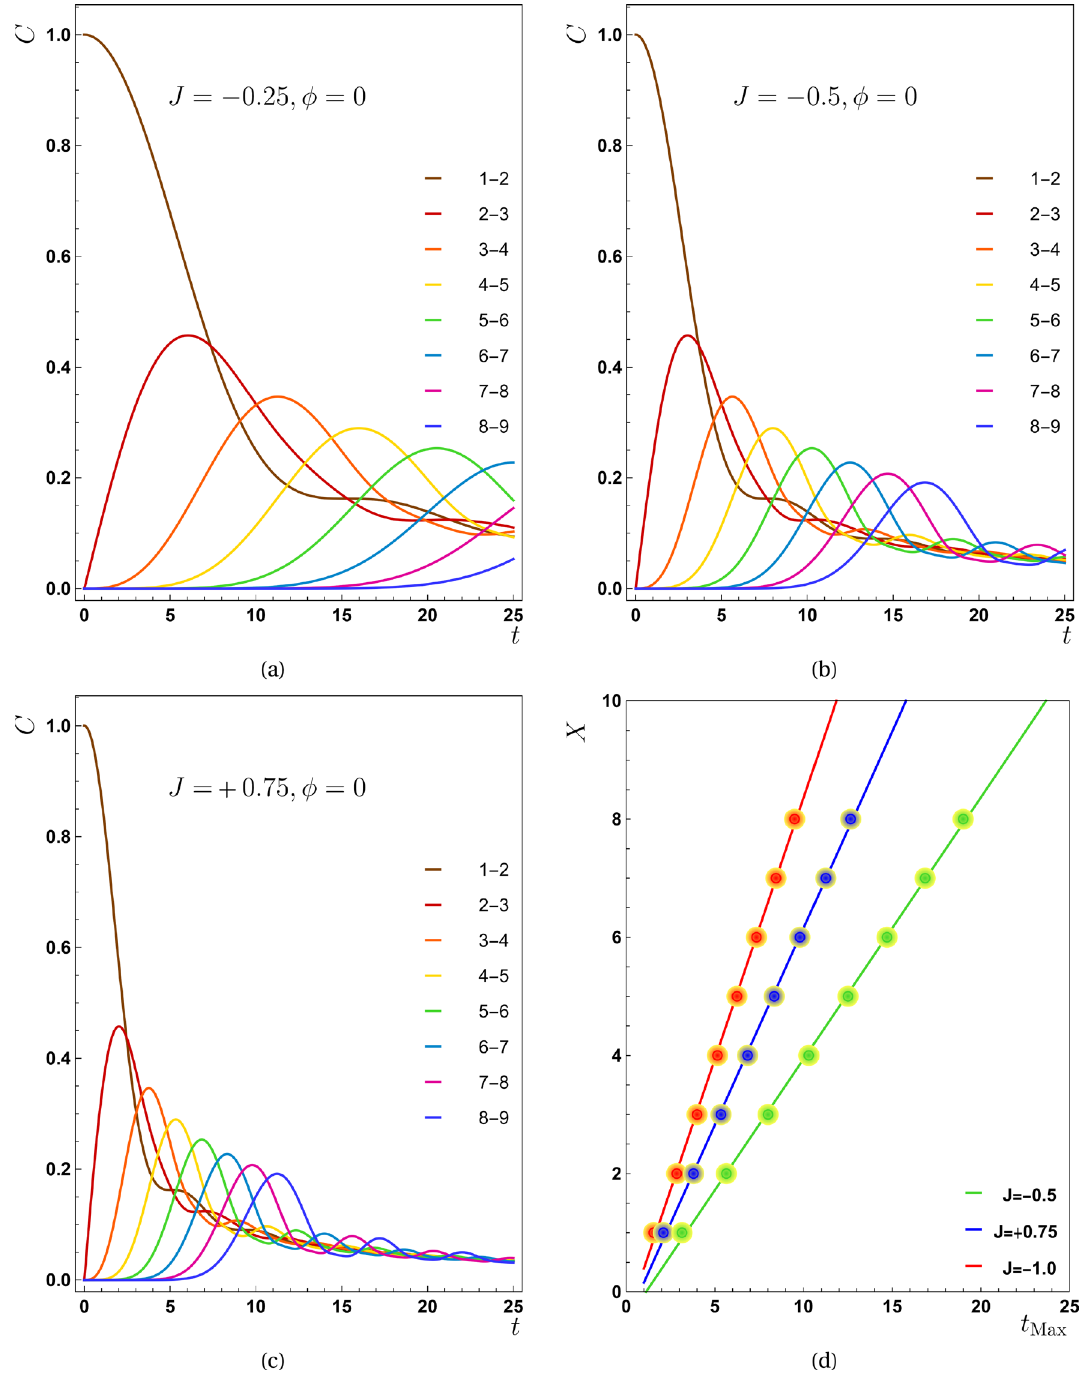
0.25 , ( b ) 0, D 0 ) the concurrence as a function of time t ( a ) J Figure 1. In the first scenario ( J = − = = 0.5 , ( c ) J 0.75 . As can be seen, the maximum value of the concurrence function for the various pairs J = − = occurs in the shorter time instances as J increases, and the graphs become more compact as a result. The t Max for different values of exchange interaction is presented in panel ( d ), from which the value diagram of X − 0.0005 , for J 0.5 is 0.4410 0.75 and J 1.0 , this quantity equals with of propagation speed for J ± = − = = − 0.6620 0.0005 and 0.8830 0.0005 respectively and for all plots φ 0 ± ± =